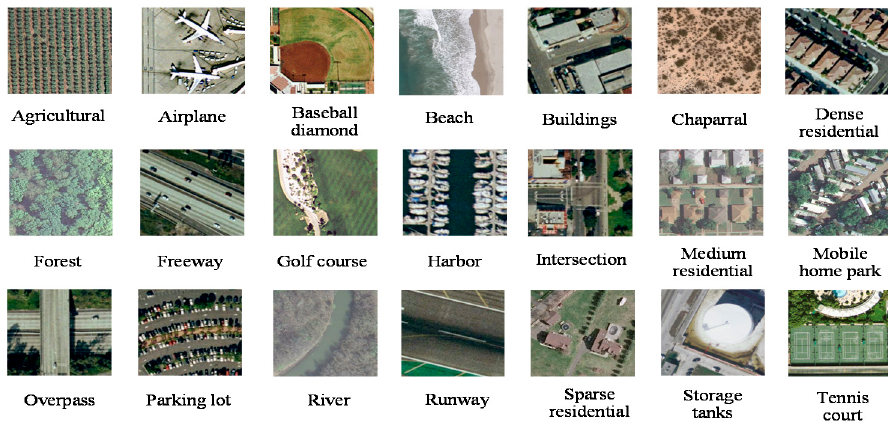
Figure 4. UC Merced Land-Use Dataset.